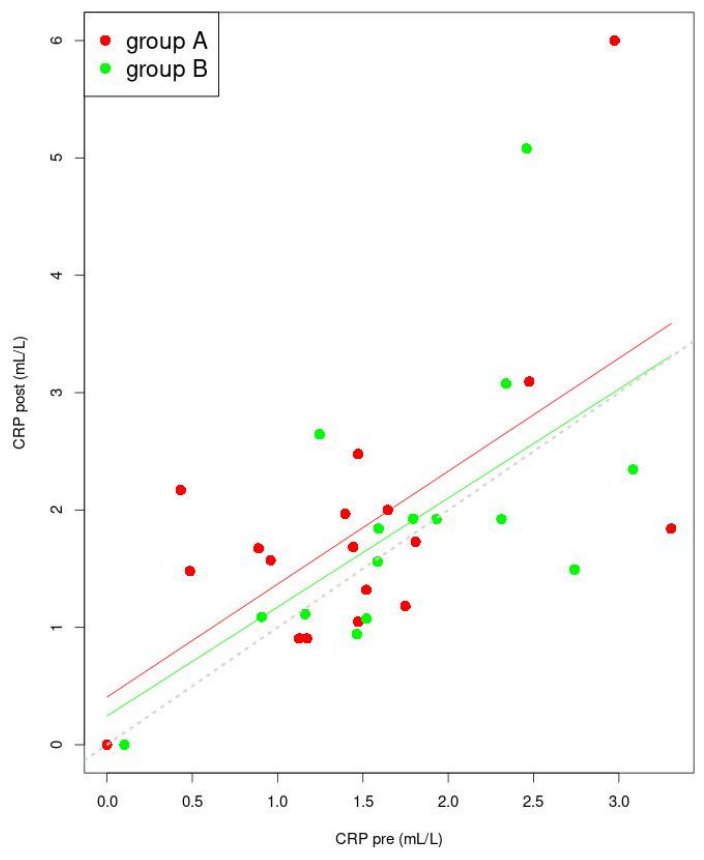
Figure 5. Linear model for CRP (post dependence on pre). The lines indicate the predicted trend of changes of “pre” and of “post” values (red for group A and green for group B). The dashed grey line is the set of points for which the pre and post values are identical. Points for group A were marked in red, while points for group B were marked in green. Abbreviation: CRP—C-reactive protein. Table 6. Linear Model for 17- β